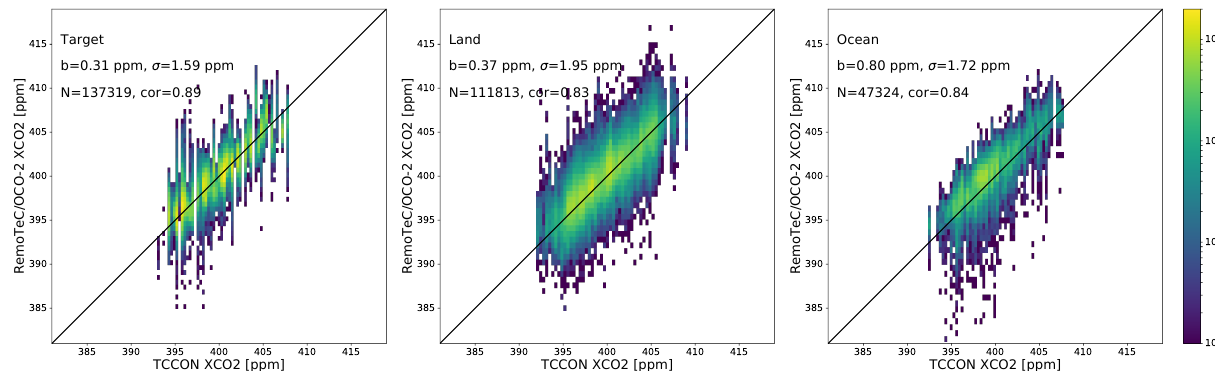
Figure 2. Validation of individual X CO retrieved from OCO-2 measurements with collocated TCCON data before bias correction. Here, 2 target retrievals are separated intentionally from land retrievals results, which thus include only measurements obtained under nadir and glint modes. Ocean retrievals only include glint mode observations over ocean. For retrievals collocated with multiple TCCON stations, we use data from the closest station. The bias (b), sounding precision ( σ ), number of points ( N ), the Pearson correlation coefficient (cor) and one-to-one line are included. Different colors represent the frequency of point